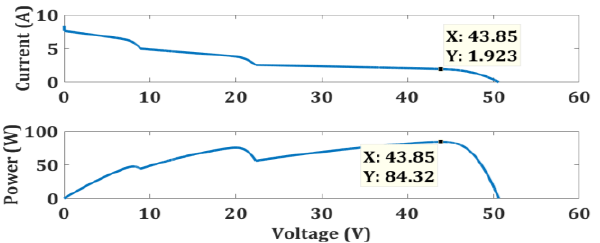
Fig. 11. Characteristic curves of a 4S2P PV array in strong partial shading